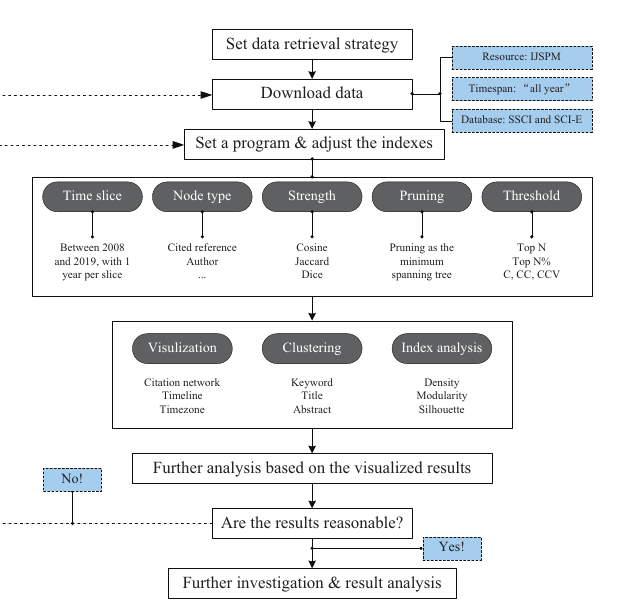
Figure 1. Architecture diagram of the data analysis